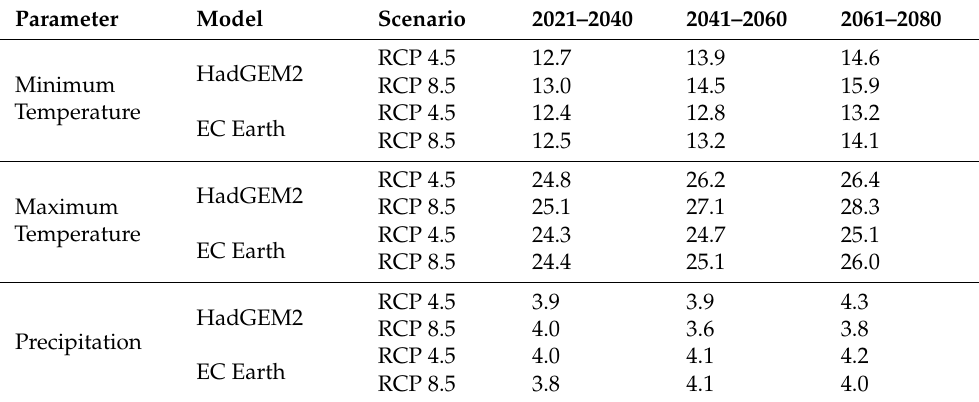
Table 2 . Summary of change in minimum and maximum temperature and average precipitation during 2021-2040, 2041-2060 and 2061-2080 for climate scenarios: RCP 4.5 and RCP 8.5 of GCM models: HadGEM2 and EC-Earth .